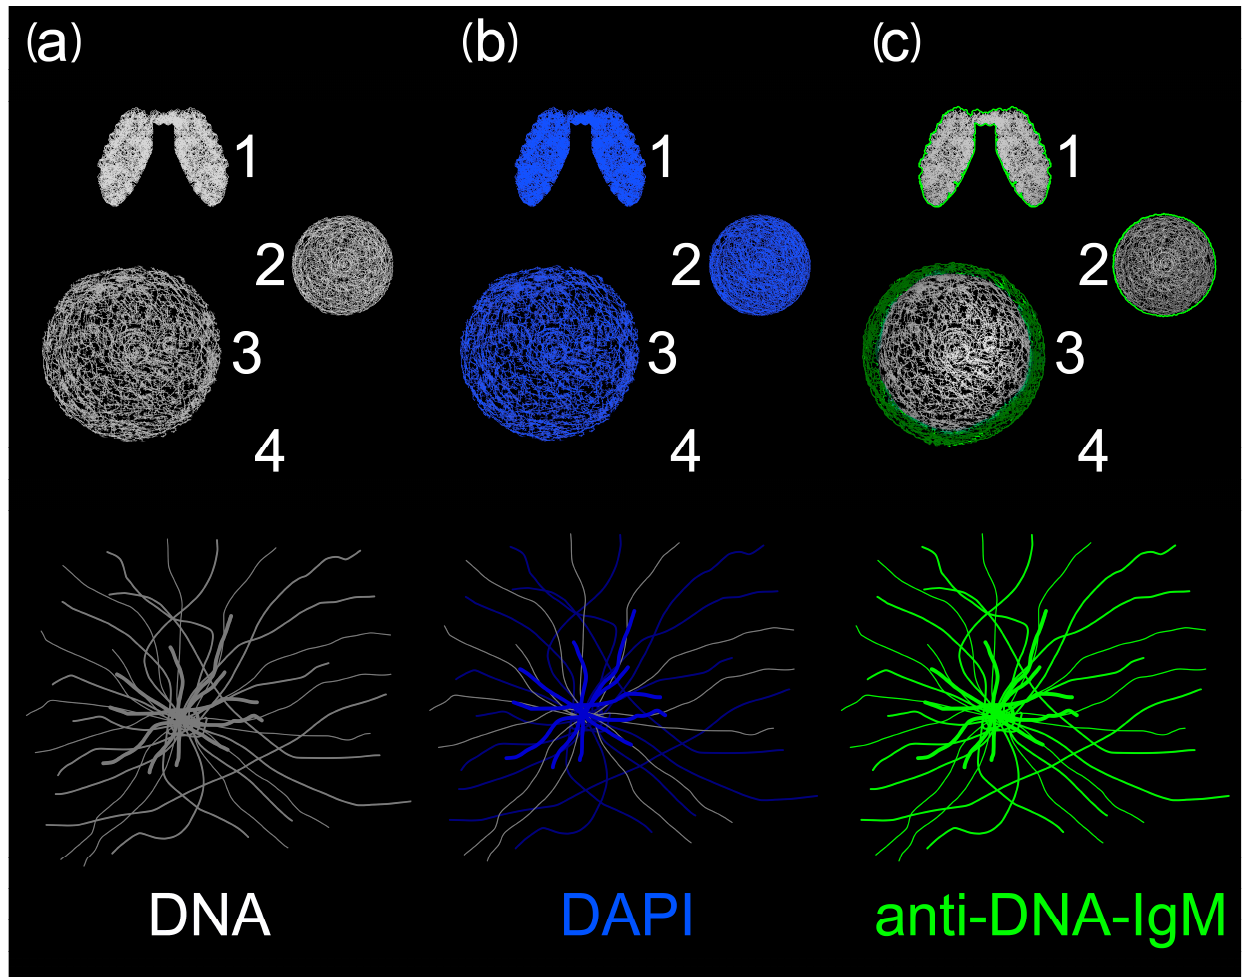
Figure 3. Morphometry revealed the advantage of anti-DNA-IgM for the detection of decondensed DNA. ( a ) DNA is indicated using the mean fluorescence intensity (MFI) of DAPI and anti-DNA as three classifications—ecDNA (red), DNA patches (blue), and nuclear (condensed) DNA (black). ( b ) Distribution of three forms of DNA with DAPI, anti-DNA-IgM, and anti-H2B-IgG. When compared to anti-DNA-IgM, DAPI displays a high fluorescence for chromatin from condensed nuclei. In addition, anti-DNA-IgM exhibits an analogous fluorescence profile of ecDNA with anti-H2B.